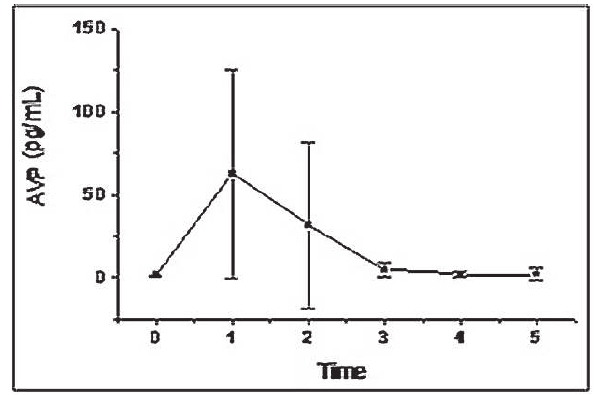
Fig. 1 – Plasmatic vasopressin concentrations Plasmatic vasopressin concentrations (AVP – pg/mL; mean ± SD) at different observation moments (n = 22).